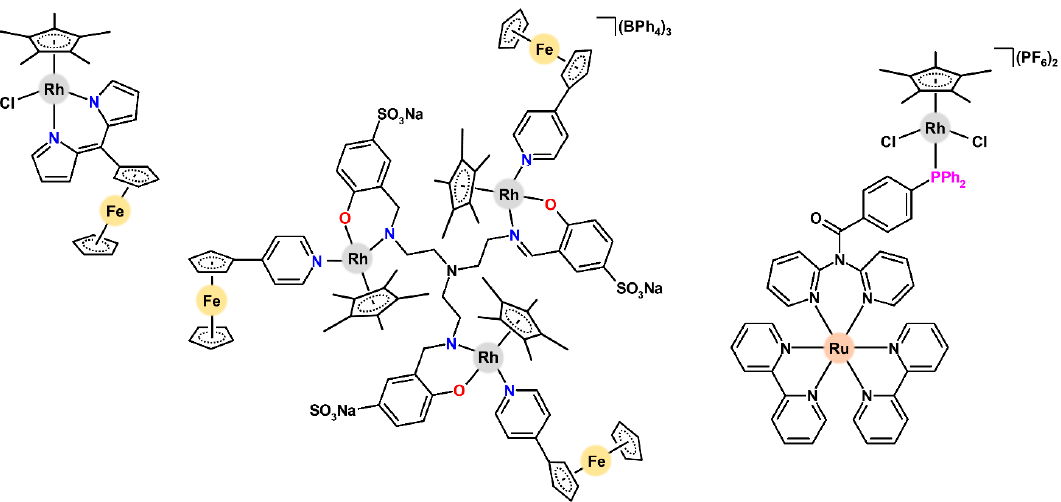
Figure 10. Structural formulas of complexes [Rh( η 5 -Cp*)Cl(Fc dpm )] (left), [Rh 3 ( μ -sai)( η 5 -Cp*) 3 (py Fc ) 3 ](BPh 4 ) 3 (middle) and [Cl 2 ( η 5 -Cp*)Rh( μ -bpy PPh3 )Ru(bpy) 2 ](PF 6 ) 2 (right), with donor atoms given in blue (N), red (O) or magenta (P).